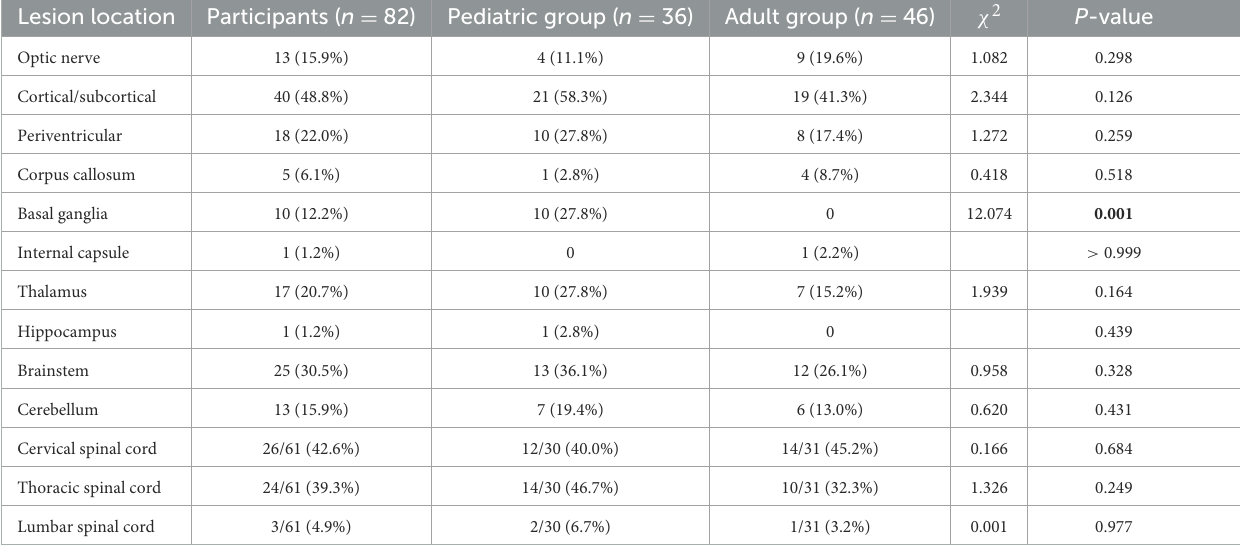
TABLE 3 Localization of brain magnetic resonance imaging lesions in patients according to age